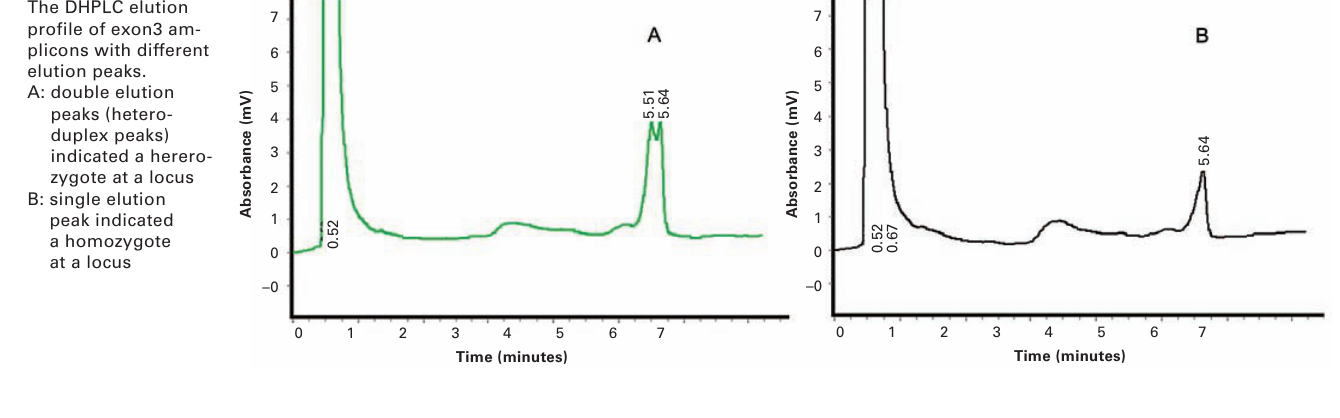
Figure 2 Partial results of DNA sequencing of exon3 amplicons. The arrows showed hererozygote AG (above) and homo- zygote AA (below) in the DNA sequence.